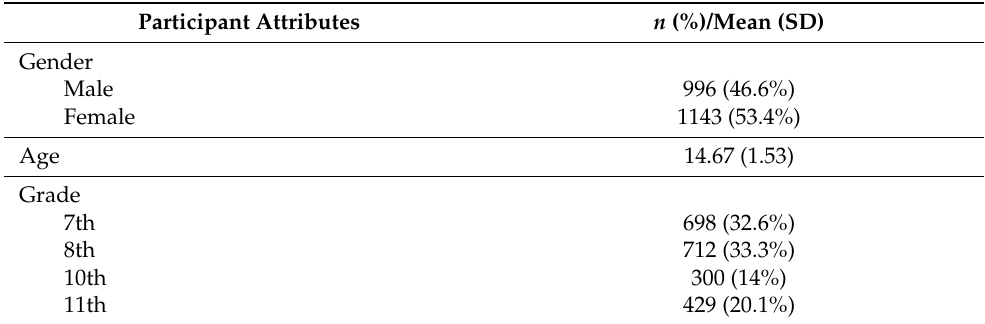
Table 1. Participant attributes in the present study.